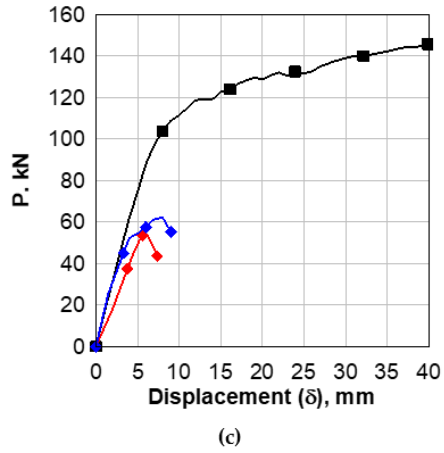
Figure 7. Load versus Mid-Span Deflection of Beams with Shear-Zone Opening. ( a ) opening 360 ×